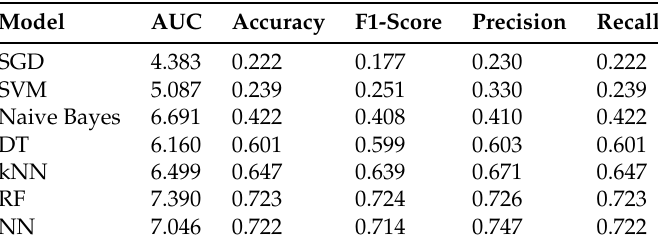
Table 11. Classification results using processed accelerometer, gyroscope, magnetometer, and light measurements.